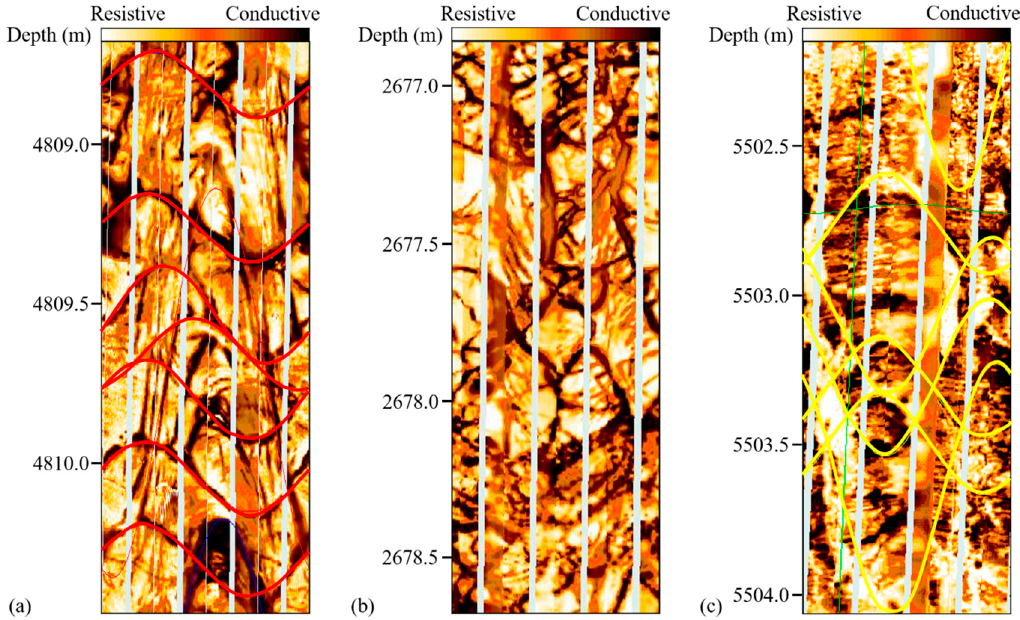
Figure 7. Tectonic fractures in borehole image logs. ( a ) Tectonic fractures are conductive in Well R8. The red sinusoidal curves represent recognized fractures. ( b ) Tectonic fractures that are not filled link together like a network in Well R15. ( c ) Tectonic fractures in Well R3. The yellow sinusoidal curves represent the fractures filled by minerals.